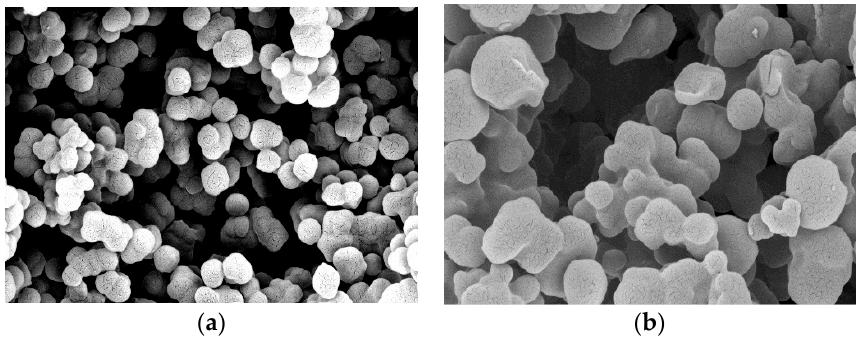
Figure 2. SEM images of ( a ) MIP and ( b ) NIP beads.